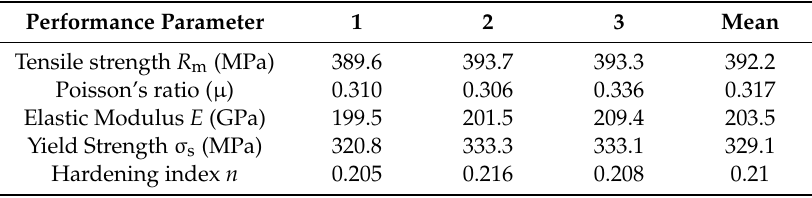
Table 1. Mechanical properties of